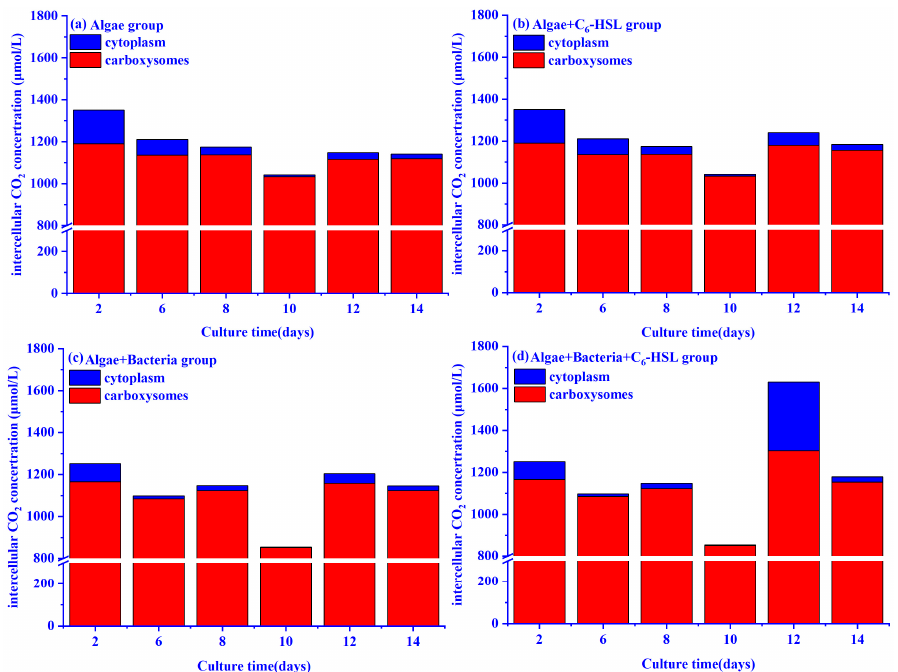
Figure 8. E ff ect of 10 ng/L C 6 -HSL on the intracellular (cytoplasm and carboxysomes) CO 2 concen-